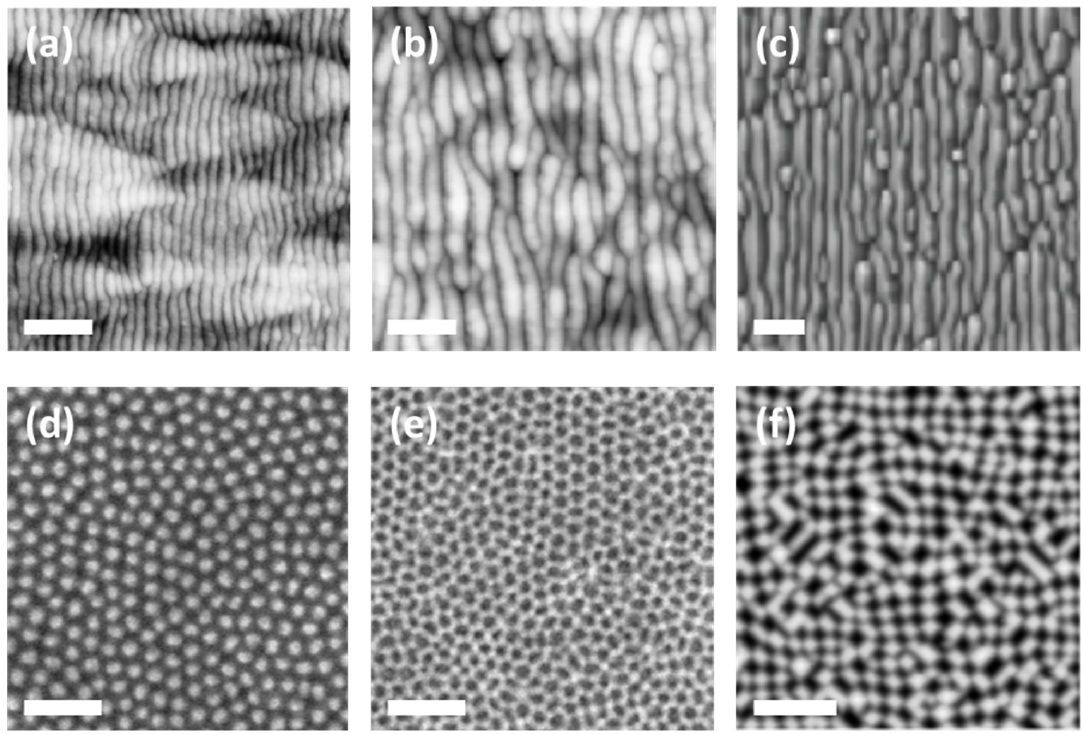
Figure 1. Different nanopatterns obtained on different surfaces by ion beam irradiation. ( a ) Nanoripple pattern on a Si surface obtained by irradiation with 500 eV Ar + at 67° incidence with respect to the surface normal. Reproduced from Ref. [78]. Scale bar 200 nm. ( b ) Nanoripple pattern on a fused silica surface obtained by irradiation with 1 keV Ar + at 45° incidence with respect to the surface normal. Scale bar 200 nm. Republished with permission of IOP Publishing, Ltd., from Ref.